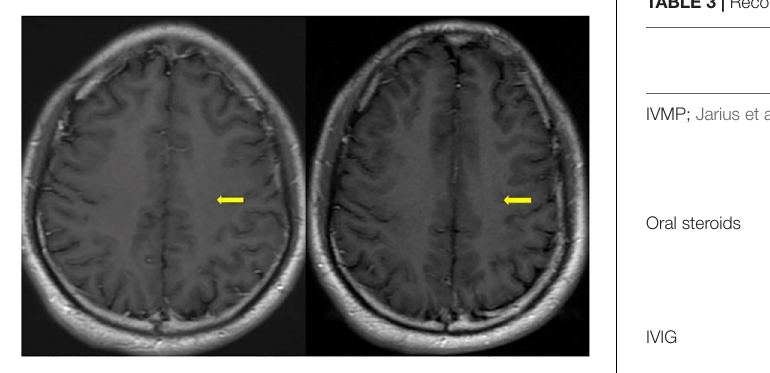
FIGURE 2 | One month later (left) and three months later (right) axial T1-contrast weight images showed nodular enhancement disappeared (yellow arrowhead) after hormone therapy.